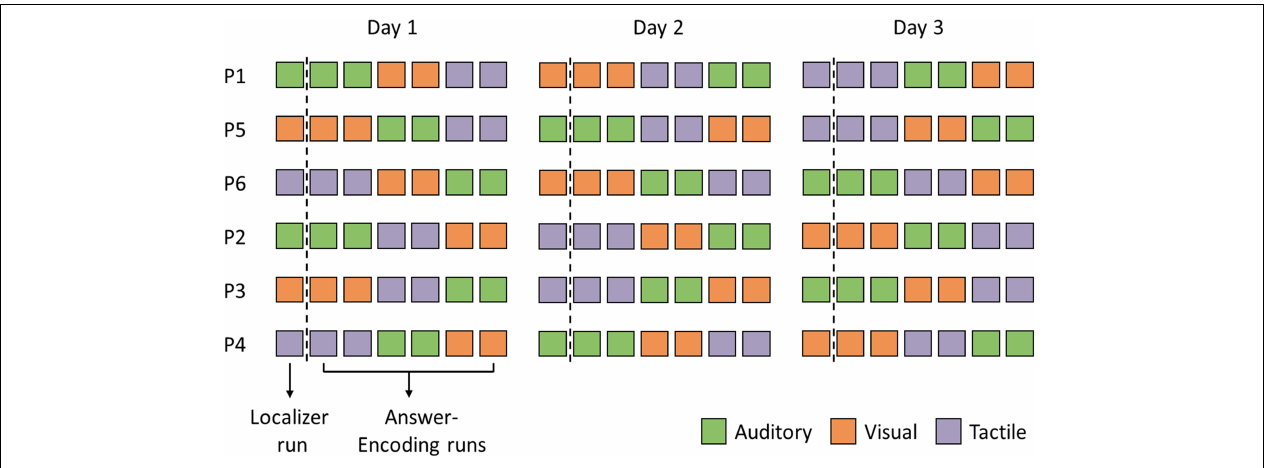
FIGURE 2 | Participant-specific experimental protocols. Each fNIRS session consisted of seven functional runs: one localizer run and six answer-encoding runs. Note that the three sensory encoding modalities, i.e., auditory (green), visual (orange), and tactile (purple), were counterbalanced across participants and sessions.